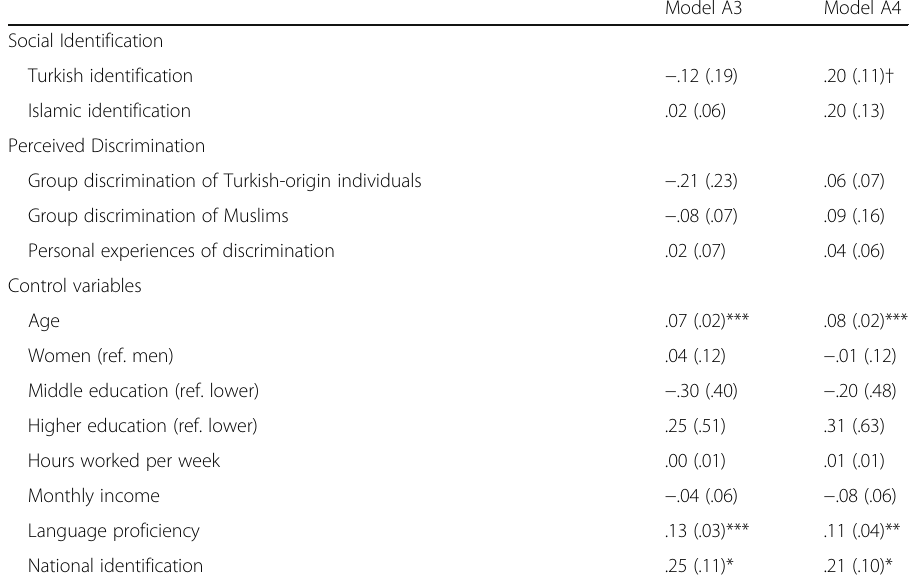
Table 10 Binary logistic regression: Interplay between social identifications, group discrimination and local voting